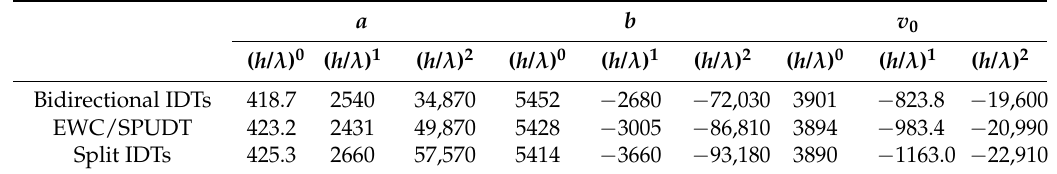
Figure 8. Frequency shifts for three types of IDTs ( a ) calculated by the extended coupling-of-mode (COM) theory and ( b ) by FEM. Table 1. Values of dispersion parameters a , b , and v 0